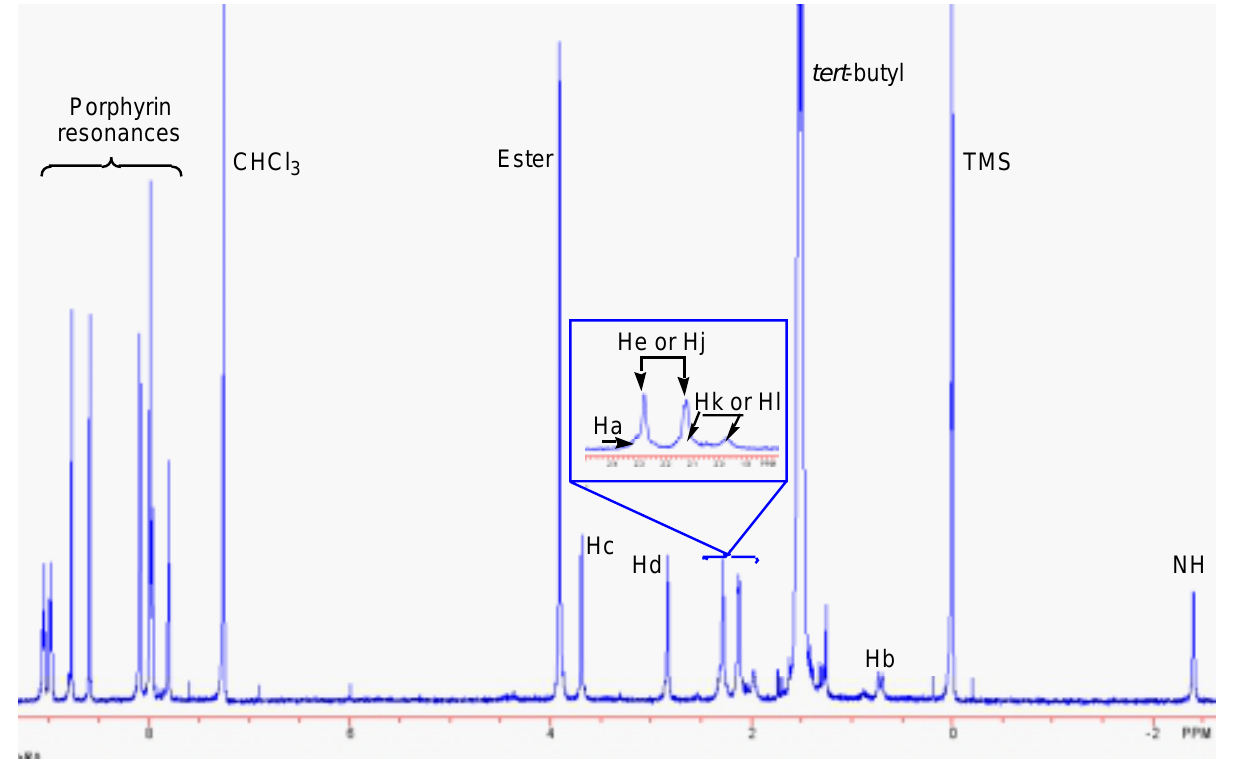
Figure 4: 1 H-NMR spectrum (300 MHz, CDCl